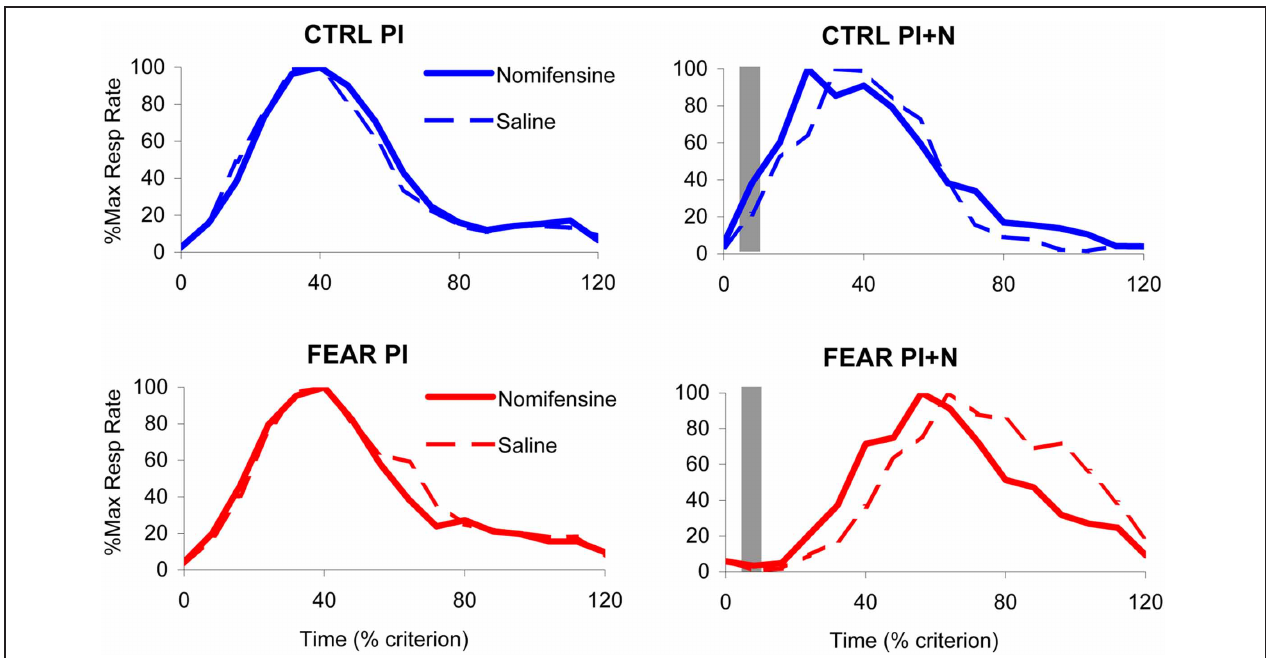
no reliable effects in either group. Right panels : Peak interval with noise (PI + N) trials (with noise): when emotionally charged (FEAR group), the distracter shifts the response function rightward considerably relative to neutral events (CTRL); nomifensine reduces the delaying effect of the distracter only when the distracter is emotionally charged (FEAR group). The gray bars indicate the presentation of the auditory